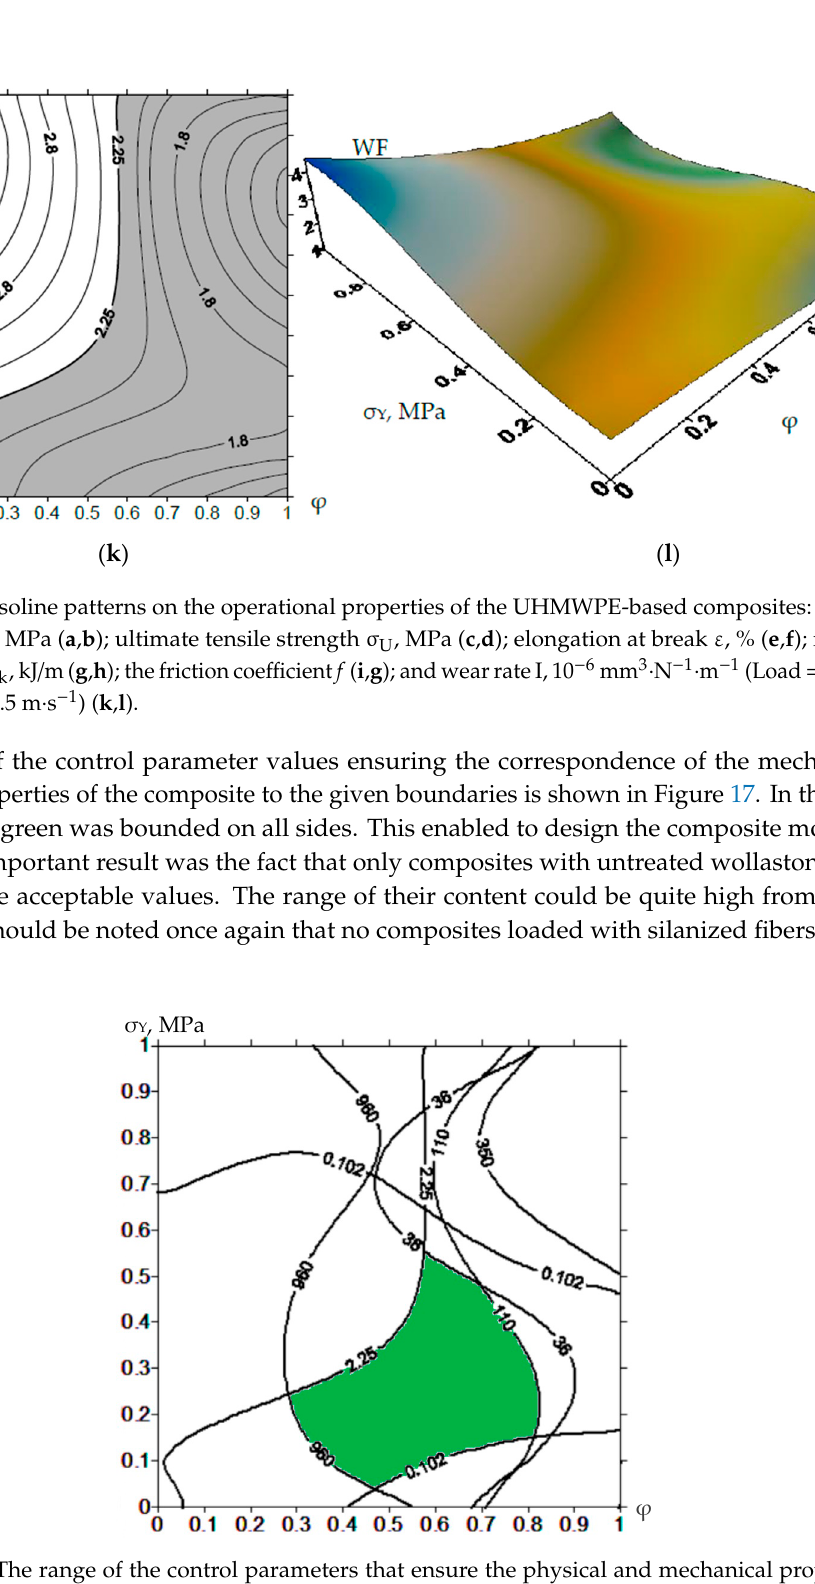
Figure 17. The range of the control parameters that ensure the physical and mechanical properties of the composites meet the specified limits for the “severe” conditions of the metal-polymer tribological loading